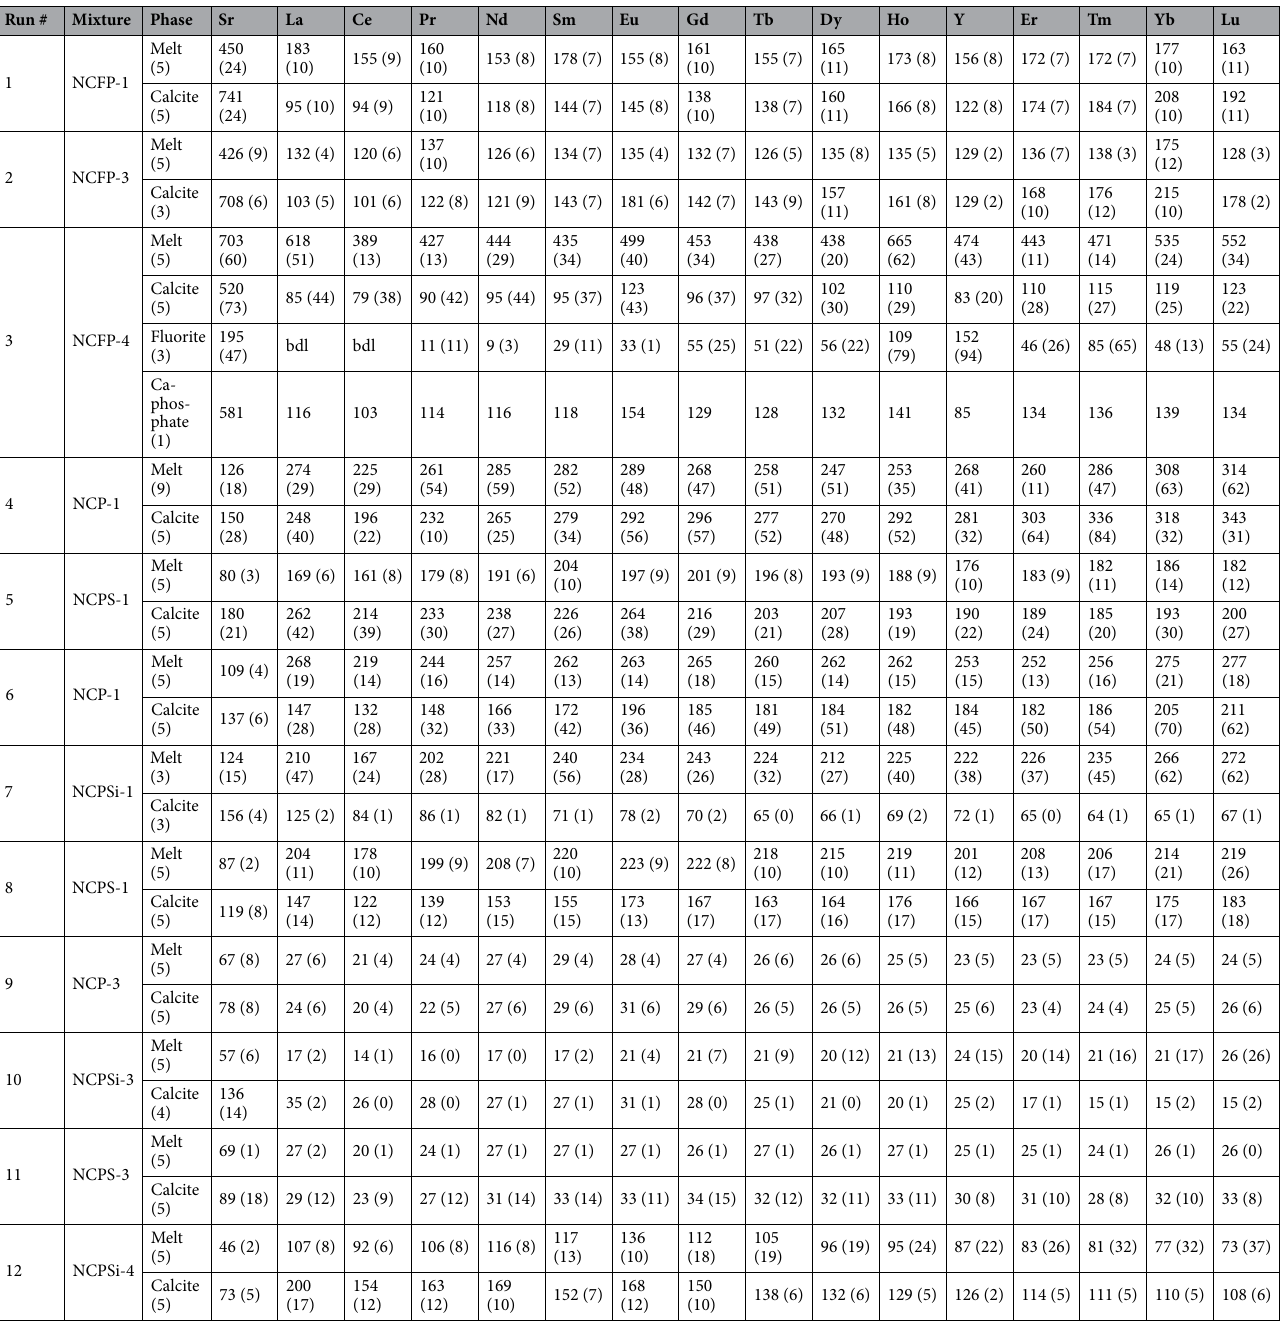
Table 4. Trace element composition of run products (in ppm). The numbers in the parentheses next to the phase name indicates the number of analyzes. The numbers in the parentheses next to the analyzes are the standard deviation. For example, 182 (48) should be read as 182 ± 48